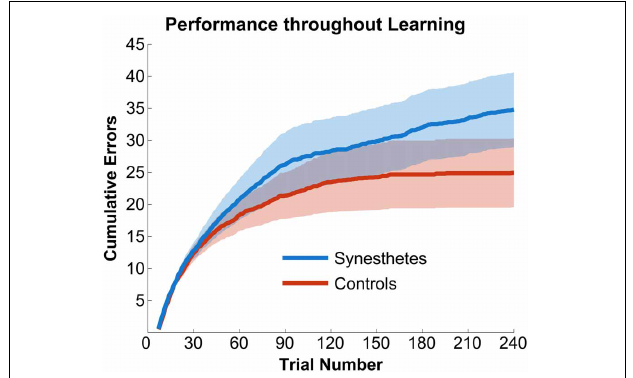
FIGURE 2 | Synesthetes (blue) and controls (red) performance as a function of time. Solid colors reflect accuracy at each trial and partially transparent colors reflect standard errors of the mean. Of note, synesthetes continued to make errors long after controls reached a plateau. The plot begins at trial number seven as the first six trials were guesses and were excluded from all analyses.